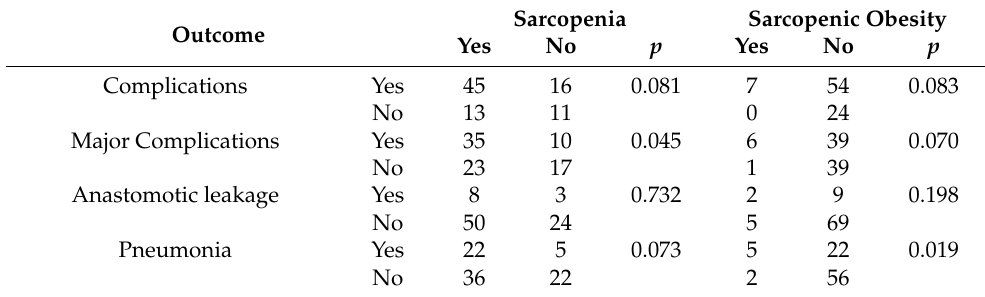
Table 3. Correlation analysis of sarcopenia and sarcopenic obesity in relation to postoperative